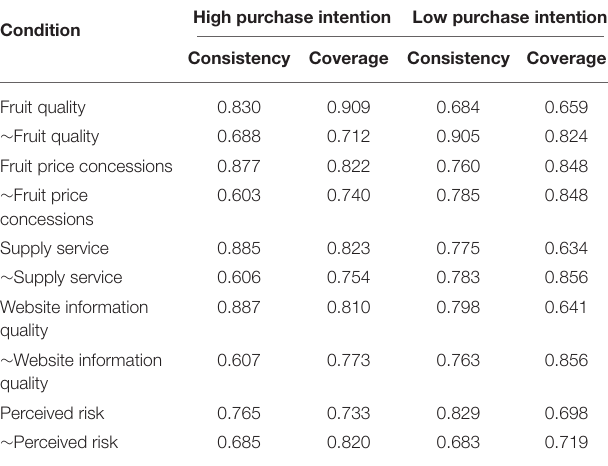
TABLE 5 | Analysis of necessary conditions. TABLE 6 | Analysis of sufficient